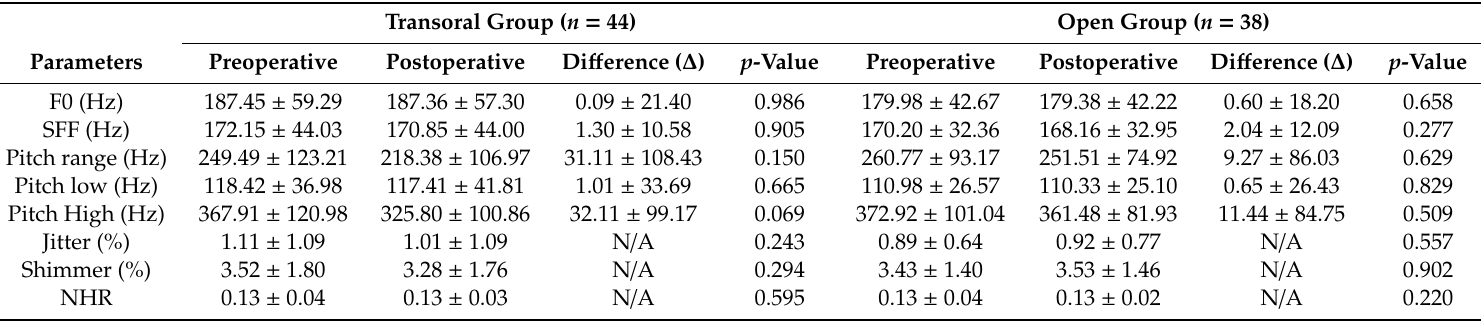
Table 3. Voice pitch changes after use of the transoral endoscopic thyroidectomy vestibular approach (TOETVA) or open